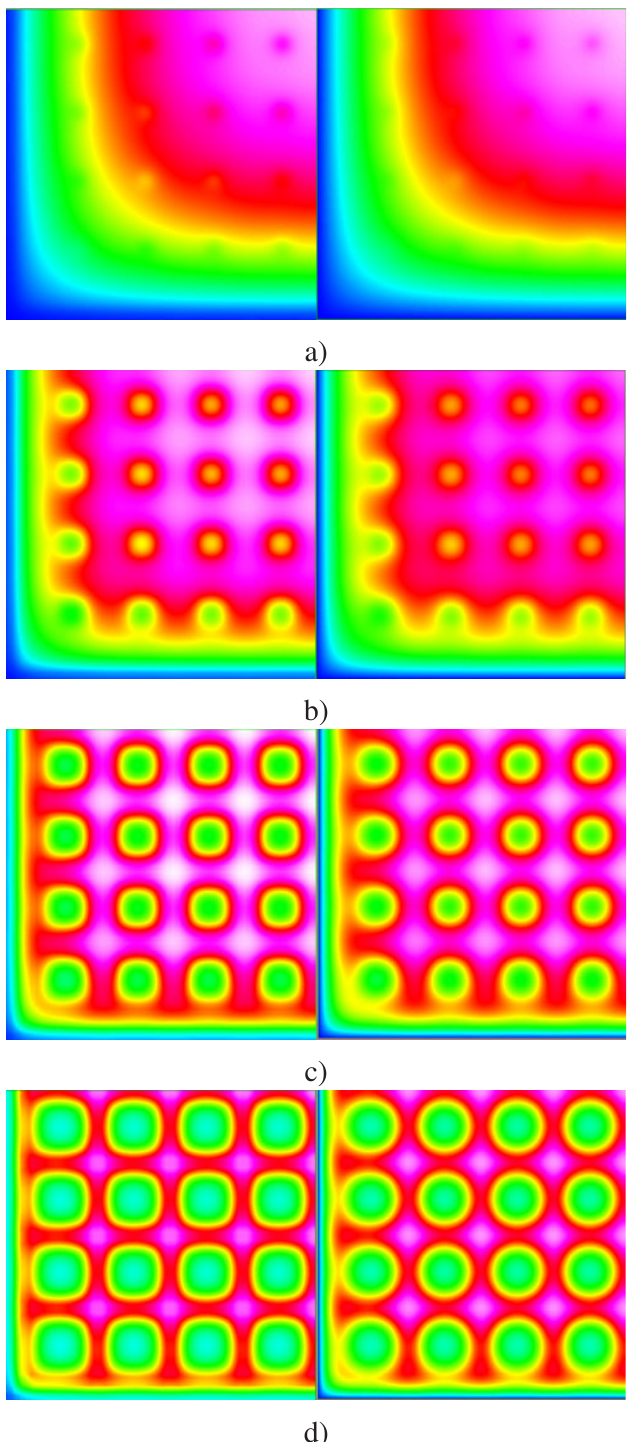
Figure 6 . Pressure pro fi les on the bottom surface simulated with the full 3D N-S solver (left) and with the PPR solver (right) for translational movement. The hole diameters are: a) 1 µ m, b) 2 µ m c) 3 µ m, and d) 4 µ m. The number of perforations N = 64 , the air gap height is h = 1 µ m, and the surface height h = 1 µ m. Simulated quarters of bottom surfaces are c